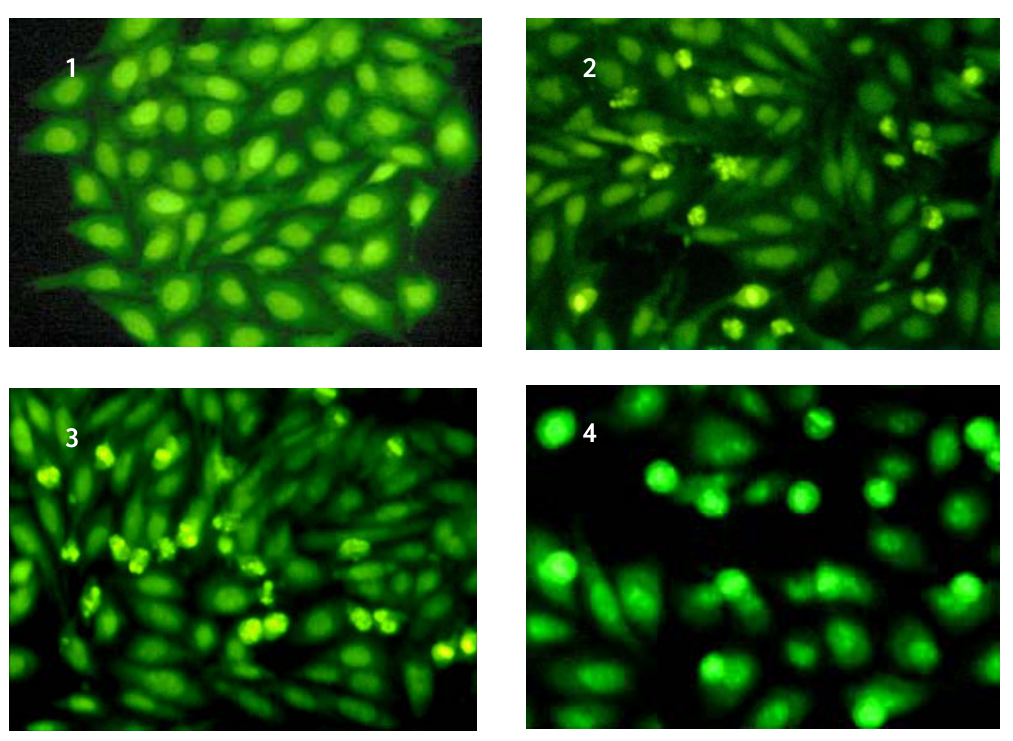
Figure 2. Morphological changes in HepG2 cell line in response to the triterpene saponins 1 and 2 . Photographs were taken under an inverted Leica fluorescence 40×10 microscope. 1) normal HepG2 cells treated with vehicle; 2) kalopanaxsaponin A, 6